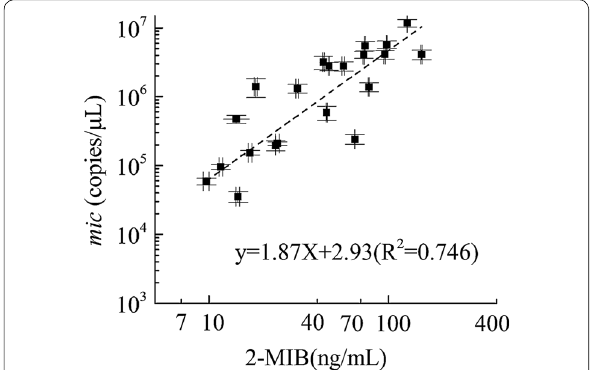
Fig. 5 Relationship between 2-MIB concentrations and Pseudanabaena sp. 2-MIB synthase gene